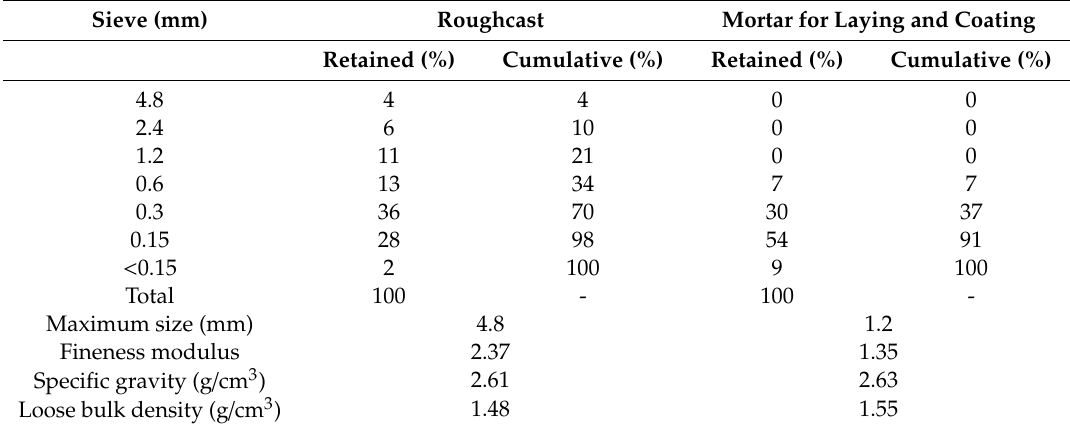
Table 2. Distribution of fine aggregates—EN 933-1 [31].